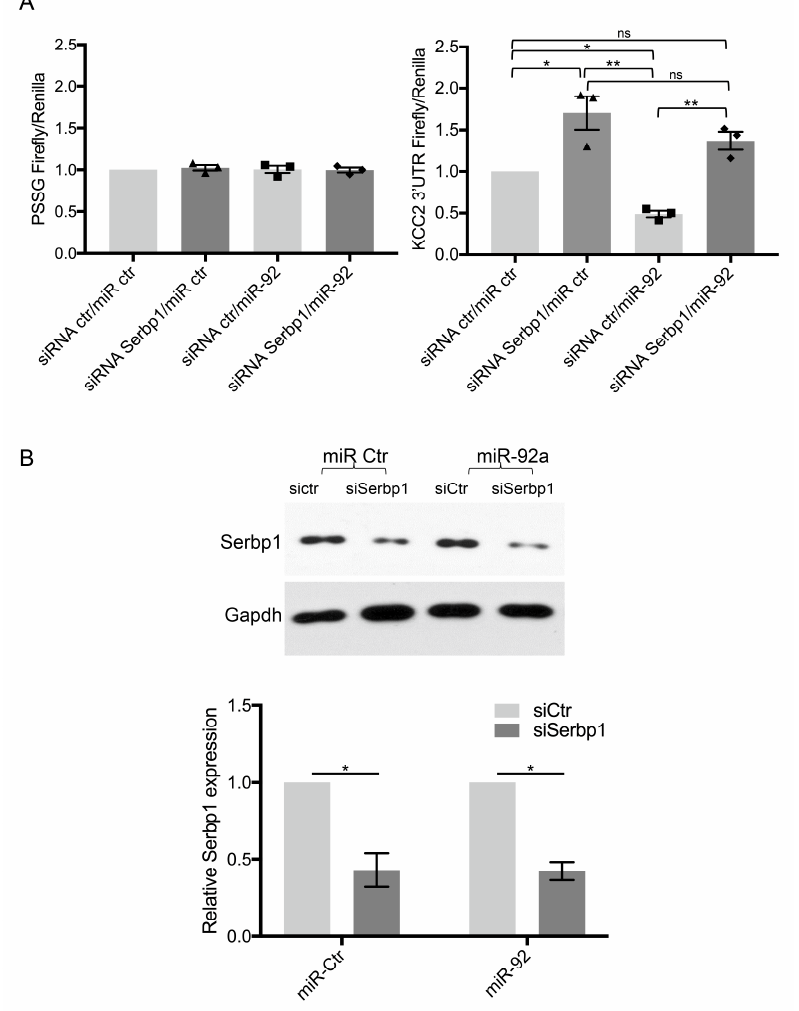
Figure 5. SERBP1 silencing relieves miR-92a-mediated translational repression of KCC2 3 ′ UTR reporter. ( A ) Forty-eight hours after transfection with control siRNA or SERBP1 siRNA (20 nM), SH-SY5Y cells were co-transfected with PSSG control plasmid or the reporter with the 3 ′ UTR of KCC2 together with a control miRNA or miR-92a. Firefly/renilla luminescence ratios were determined 24 h later. The data are normalized to cells transfected with control siRNA and control miRNA. Data represent the mean of three independent experiments ± standard error. ns : not significant, * p < 0.05; ** p < 0.01 ( t -test). Individual data points for siRNA SERBP1/miR-Ctr (triangles), siRNA Ctr/miR-92 (squares), siRNA Serbp1/miR-92 (rhombus) co-transfected cells are shown. ( B ) Representative Western blot showing the efficiency of SERBP1 silencing in SH-SY5Y used for luciferase assay. Means +/ − S.E. of SERBP1 protein levels obtained from three independent experiments are presented relative to control cells. * p < 0.05.